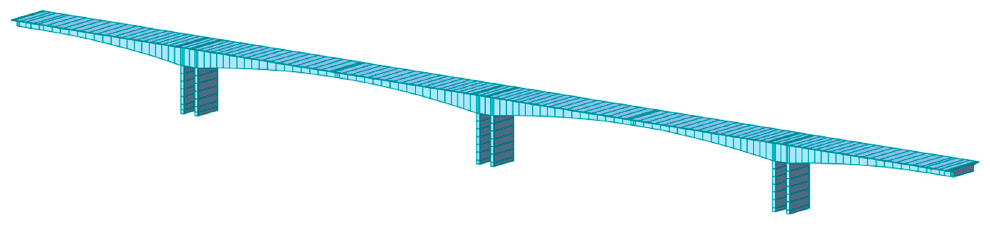
Figure 3. Hanxi Bridge: finite element model in Midas/Civil. Figure 3 . Hanxi Bridge: finite element model in Midas/Civil.